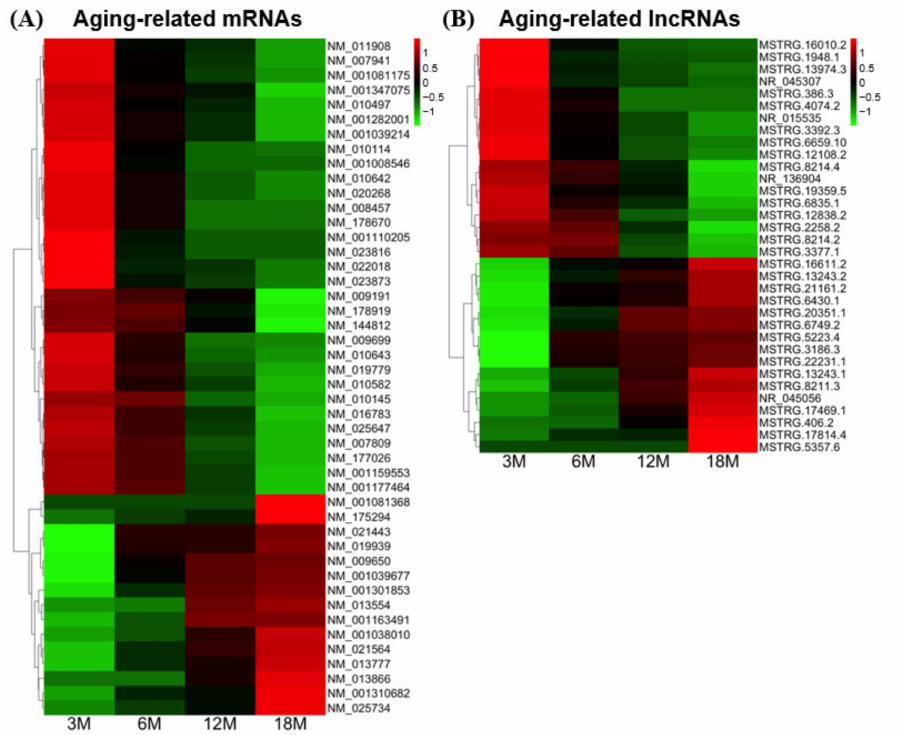
Figure 4. Heatmap showing the relative expression levels of the 46 significant aging-related mRNAs ( A ) and 34 significant aging-related lncRNAs ( B ) that exhibited differential expression in the four age groups. Red and green colors indicate higher and lower expression levels, respectively. Transcript IDs are presented on the